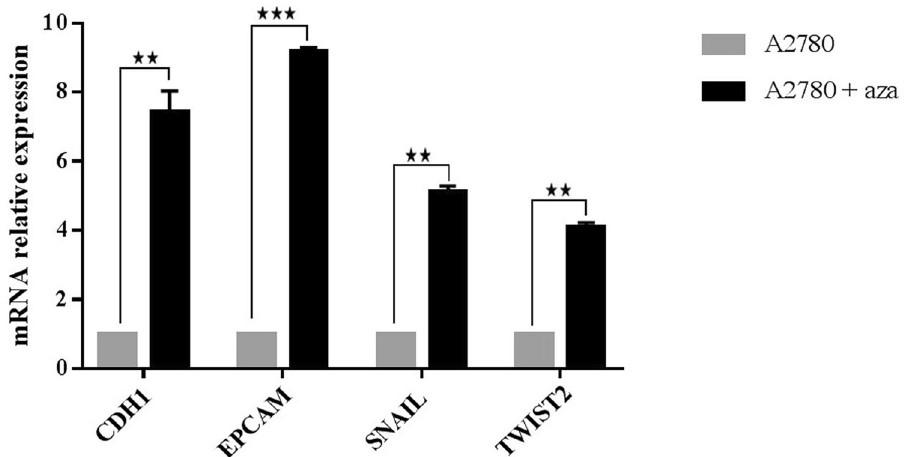
Figure 7. EMT marker gene expression changes after exposure to the demethylating agent 5-azacytidine. qPCR validation of gene expression showed a significant up-regulation of EMT genes in A2780 cells treated with azacytidine compared with